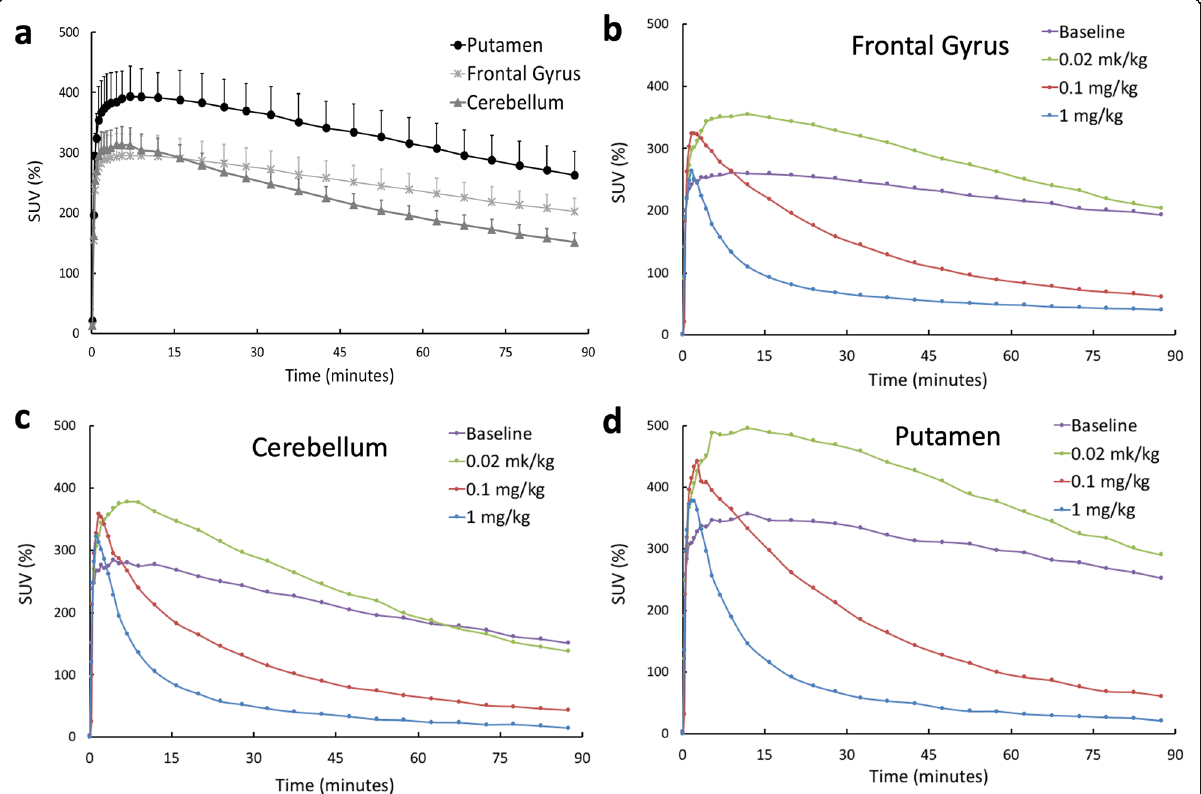
Fig. 3 a The baseline time – activity curves (TACs) of selected brain regions showing mean and standard deviation from baseline scans of three animals. b TACs of frontal gyrus from baseline and three blocking scans (Baboon3). c TACs of cerebellum from baseline and three blocking scans (Baboon3). d TACs of putamen from baseline and three blocking scans